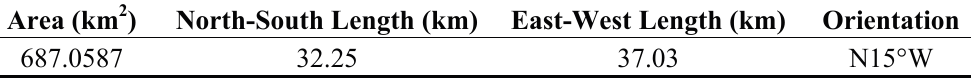
Table 2. Area, dimensions and orientation of Teshekpuk Lake.